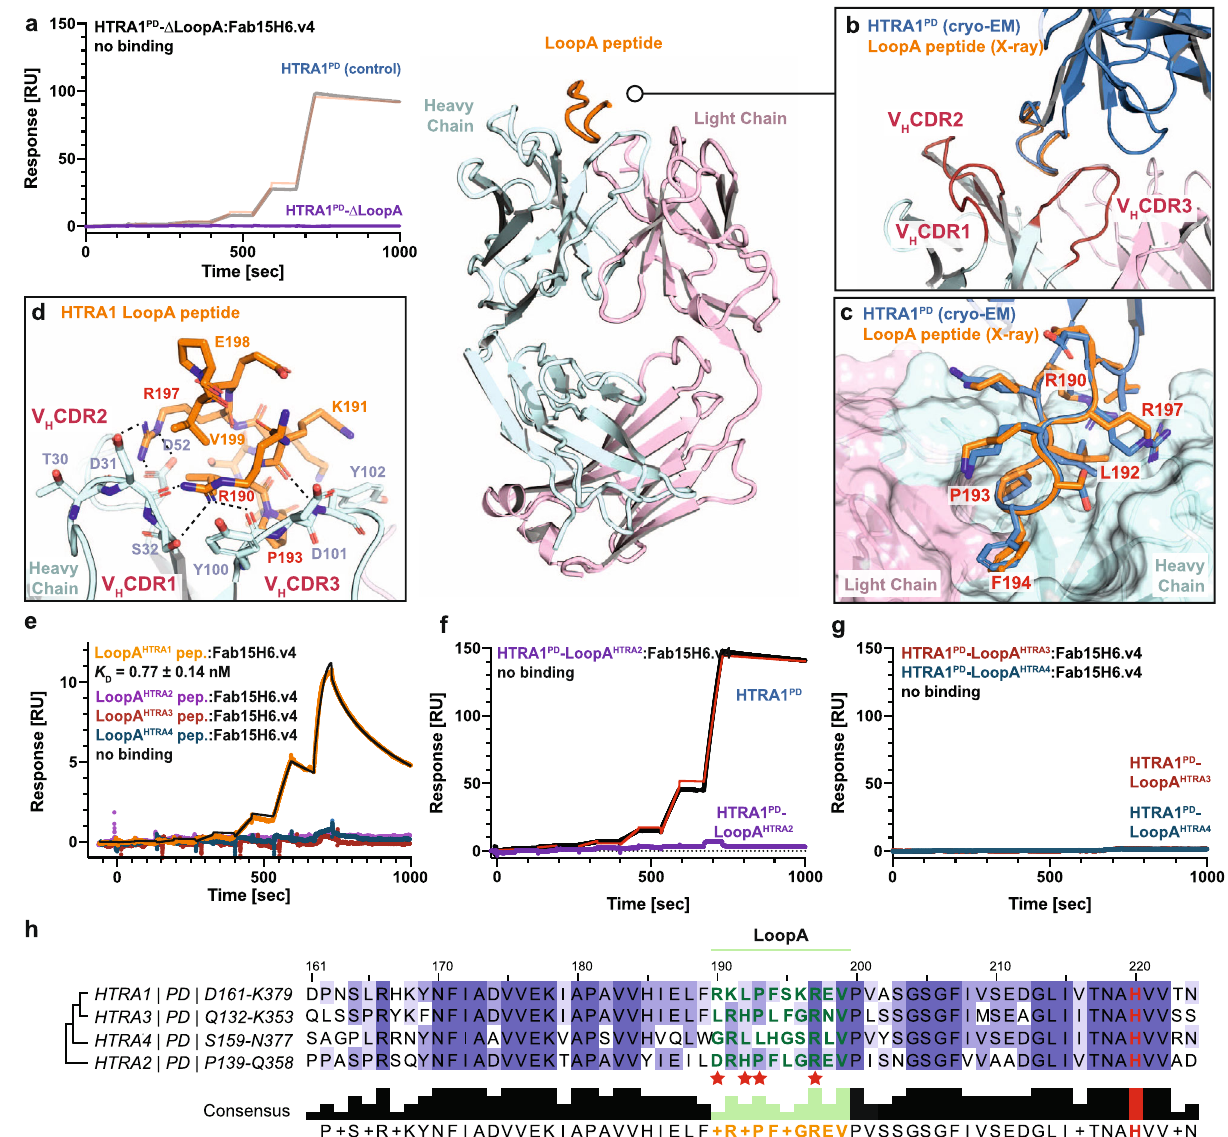
Fig. 4 | Fab15H6.v4 binds to HTRA1 LoopA epitope with high speci fi city. a SPR binding kinetics show no interaction between Fab15H6.v4 and HTRA1- Δ LoopA mutant. Overview of the co-crystal structure of Fab15H6.v4 with LoopA peptide (center). b Detail of co-crystal structure showing an excellent alignment of the LoopA peptide (orange) with the LoopA of the cryo-EM structural model (blue). In the co-crystal structure the LoopA is exclusively contacted by the Fab heavy chain (CDR1-3, red). c Side chain comparison between LoopA peptide of the co-crystal structure (orange) and LoopA of the cryo-EM structural model (blue) with key residues labeled in red. d Key residues between LoopA and Fab15H6.v4 based on the co-crystal structure include R190, L192, P193 and R197 (labeled red). e SPR